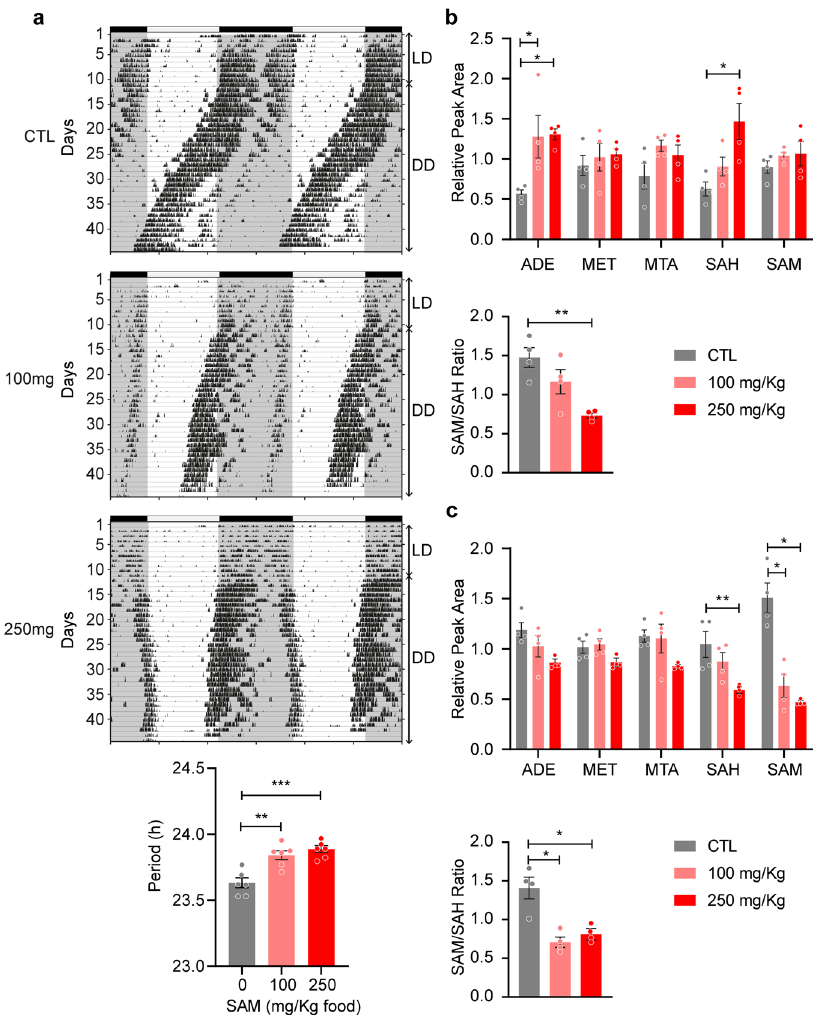
Fig. 6 SAM supplementation affects circadian behavior in vivo. a Representative running wheel activity records (actograms) of mice fed control (CTL) diet, or the same diet enriched with 100 or 250 mg/kg food, as indicated. Actograms are double-plotted, fi rst recorded under standard light-dark conditions (LD, days 0 to 10) followed by constant darkness (DD, days 11 to 45). Black tick marks inside the actograms represent bouts of wheel-running activity. Periods of light and dark are indicated by horizontal bars above actograms, and the timing of the original light-dark cycles is indicated by grayed areas. Bar chart shows mean circadian period + / − S.E.M. of n = 6 male mice, analyzed by one-way ANOVA ( p < 0.001) followed by Bonferroni multiple comparison test, ** p < 0.01, *** p < 0.001. See Supplementary Fig. 8 for raw actograms of all animals. b Metabolites quanti fi cation from the liver and hypothalamus ( c ) of mice fed control diet, or the same diet enriched with SAM at 100 or 250 mg/kg food for 3 weeks. Lower graphs in each panel show SAM/SAH ratio. Bar chart shows mean + / − S.E.M. of n = 2 male mice + 2 female mice, analyzed for each metabolite by one-way ANOVA followed by Bonferroni